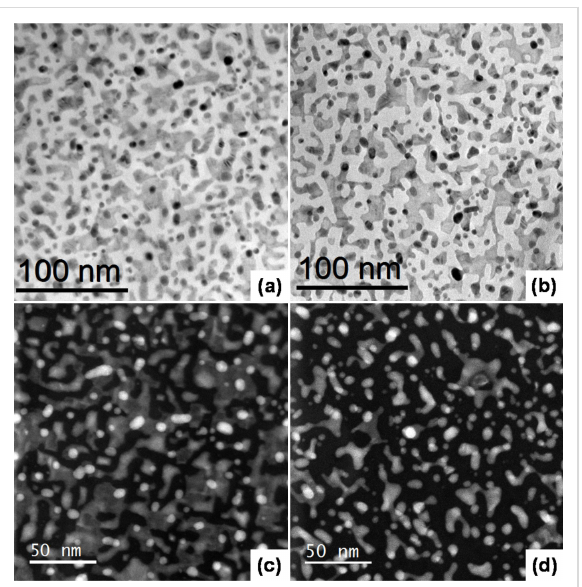
Figure 4: Plan view TEM of Si sample with Au islands obtained with 20 s immersion in the plating solution (a); the same sample after a HF postdeposition treatment of 70 s (b) and (c) and (d) STEM image of (a) and (b), respectively.